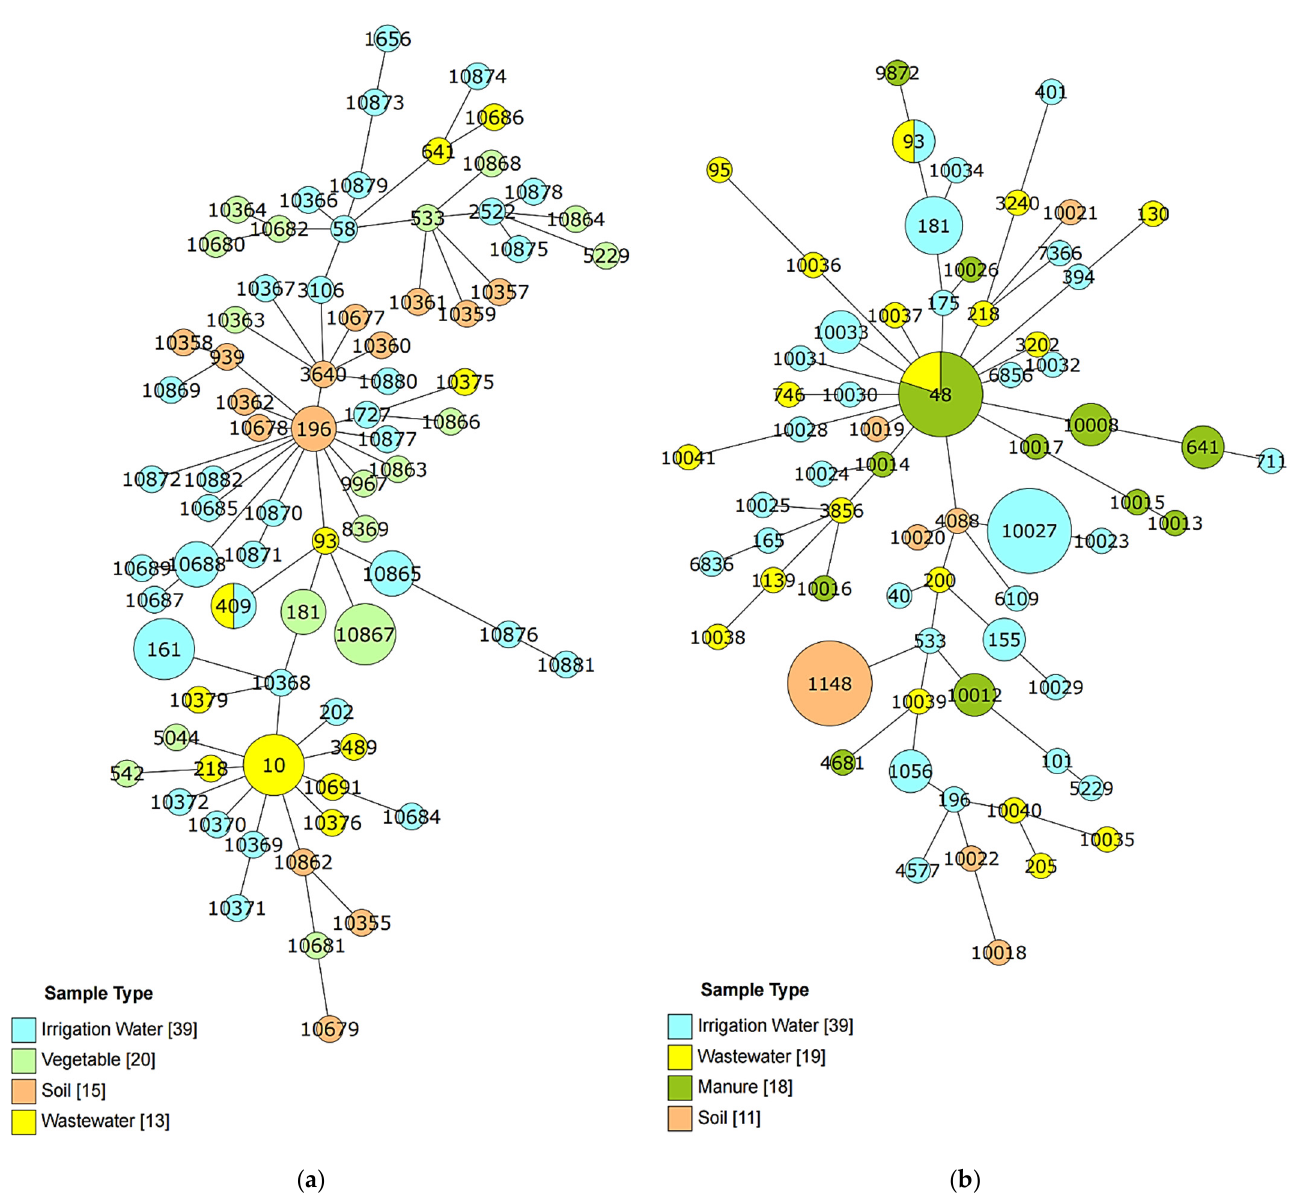
Figure 3. GrapeTree phylogeny constructed using sequence types (STs) identified by multilocus sequence typing during ( a ) the dry season and ( b ) the wet season and their relation in different samples. Each node represents a single ST, the number is the ST identity. The size of the node relates to the number of the isolates for each ST, i.e., the more the isolates with the same ST the bigger the size, and the color shows the sample type.